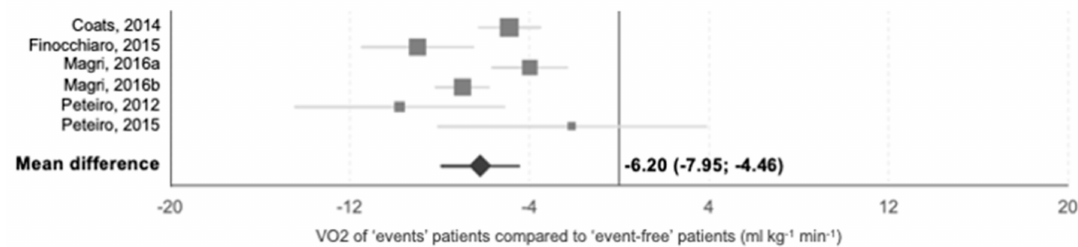
Figure 7. Random-effects meta-analysis of VO2max values of patients with recorded events during follow up compared to event-free patients. Grey squares represent mean difference between groups and its size indicates its relative weight in the meta-analysis. Grey lines intersecting them horizontally represent 95% CI for the mean differences. The black rhombus represents the mean difference of all studies, indicating that ‘events’ patients had lower VO2max than